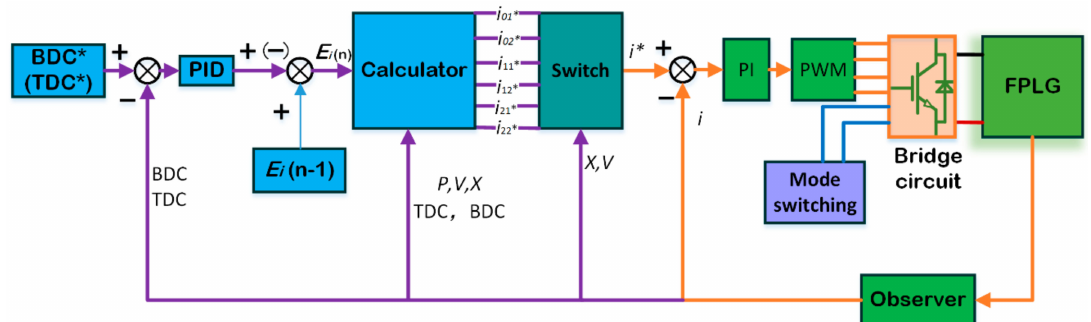
Figure 12. The control strategy of ladder-like.